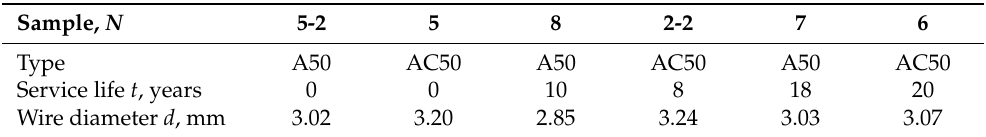
Table 2. Samples of cables of overhead power lines with different service life, which were selected for research (samples A50 are from [10,37]) 1 . Sample, N